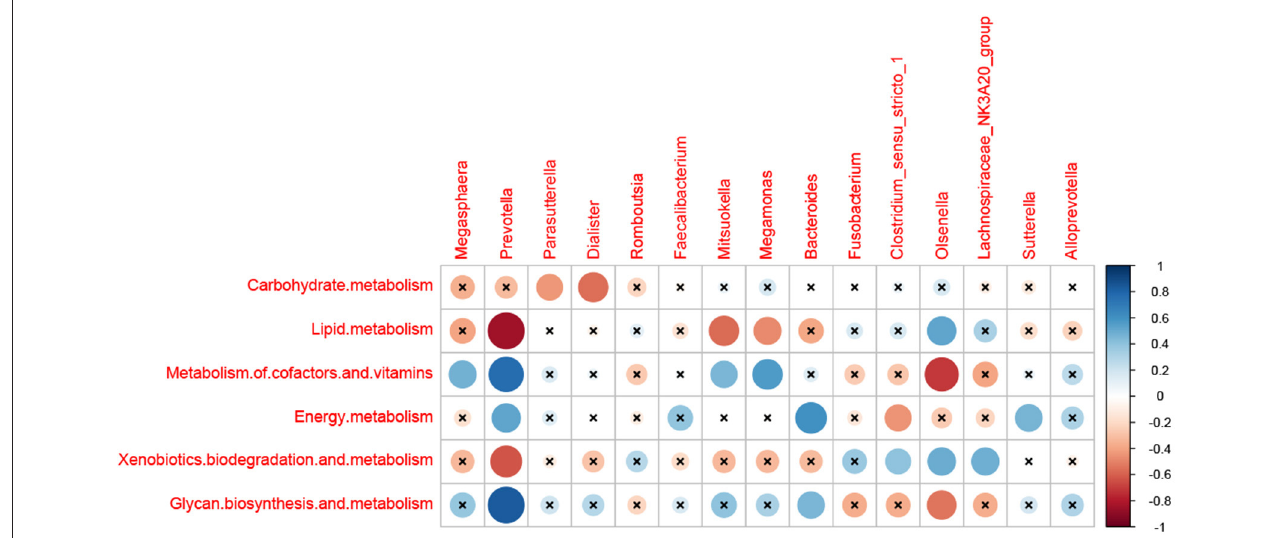
FIGURE 5 | Correlation matrix between the metabolism and the dominant microbial at 28 days of age. The abscissa is the differential flora, and the ordinate is the differential metabolisms. Blue is positive and red is